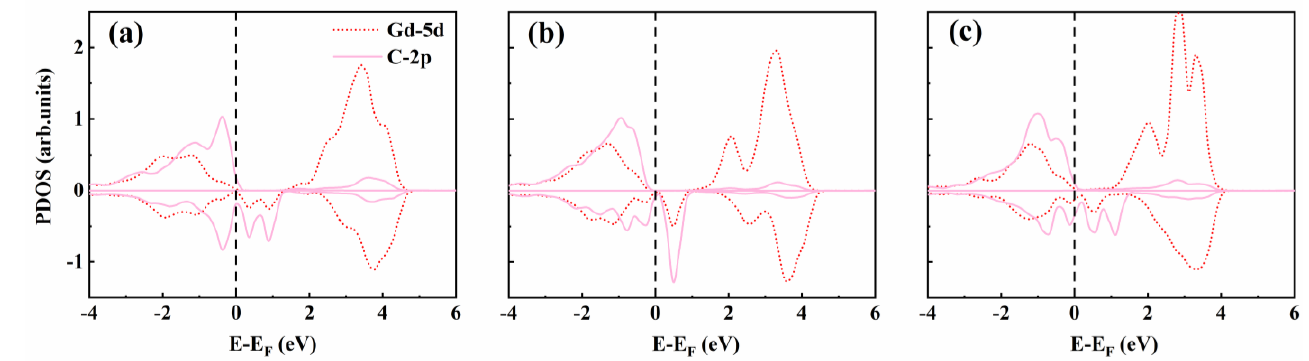
Figure 7. The PDOS of Ga 14 N 14 Gd 2 C 2 monolayers at ε = ( a ) 6, ( b ) 7 and ( c ) 15, respectively.